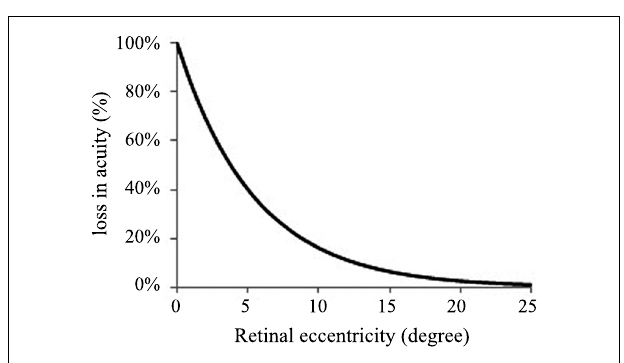
FIGURE 1 | Loss of visual acuity as a function of degrees of retinal